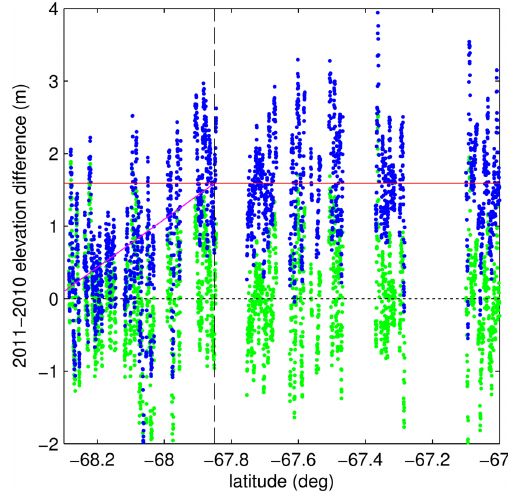
Figure 3. Correction of the elevation data in the 2011 BAS airborne survey. Blue dots show the differences between uncorrected BAS radar altimetry elevations on 27 January 2011 and IceBridge laser altimetry elevations on 13 November 2010 (using the sign conven- tion 2011 minus 2010). The 2011 survey data need to be calibrated and also have radar firn penetration removed. Assuming negligi- ble elevation change over the ∼ 10 weeks between surveys, the 2011 data are first calibrated by subtracting everywhere an offset of 1.59m (red line; the mean difference from 2010 for all data north of 67.85 ◦ S). After this calibration, the 2011 data are progressively lower than 2010 south of 67.85 ◦ S, which is attributed to radar pen- etration of the firn (Holland et al., 2011). In this region we add an additional penetration correction equal to the difference between the red and magenta lines. This correction is also applied to the 1998 BAS radar altimeter data. Green dots show the difference between the corrected 2011 data and the 2010